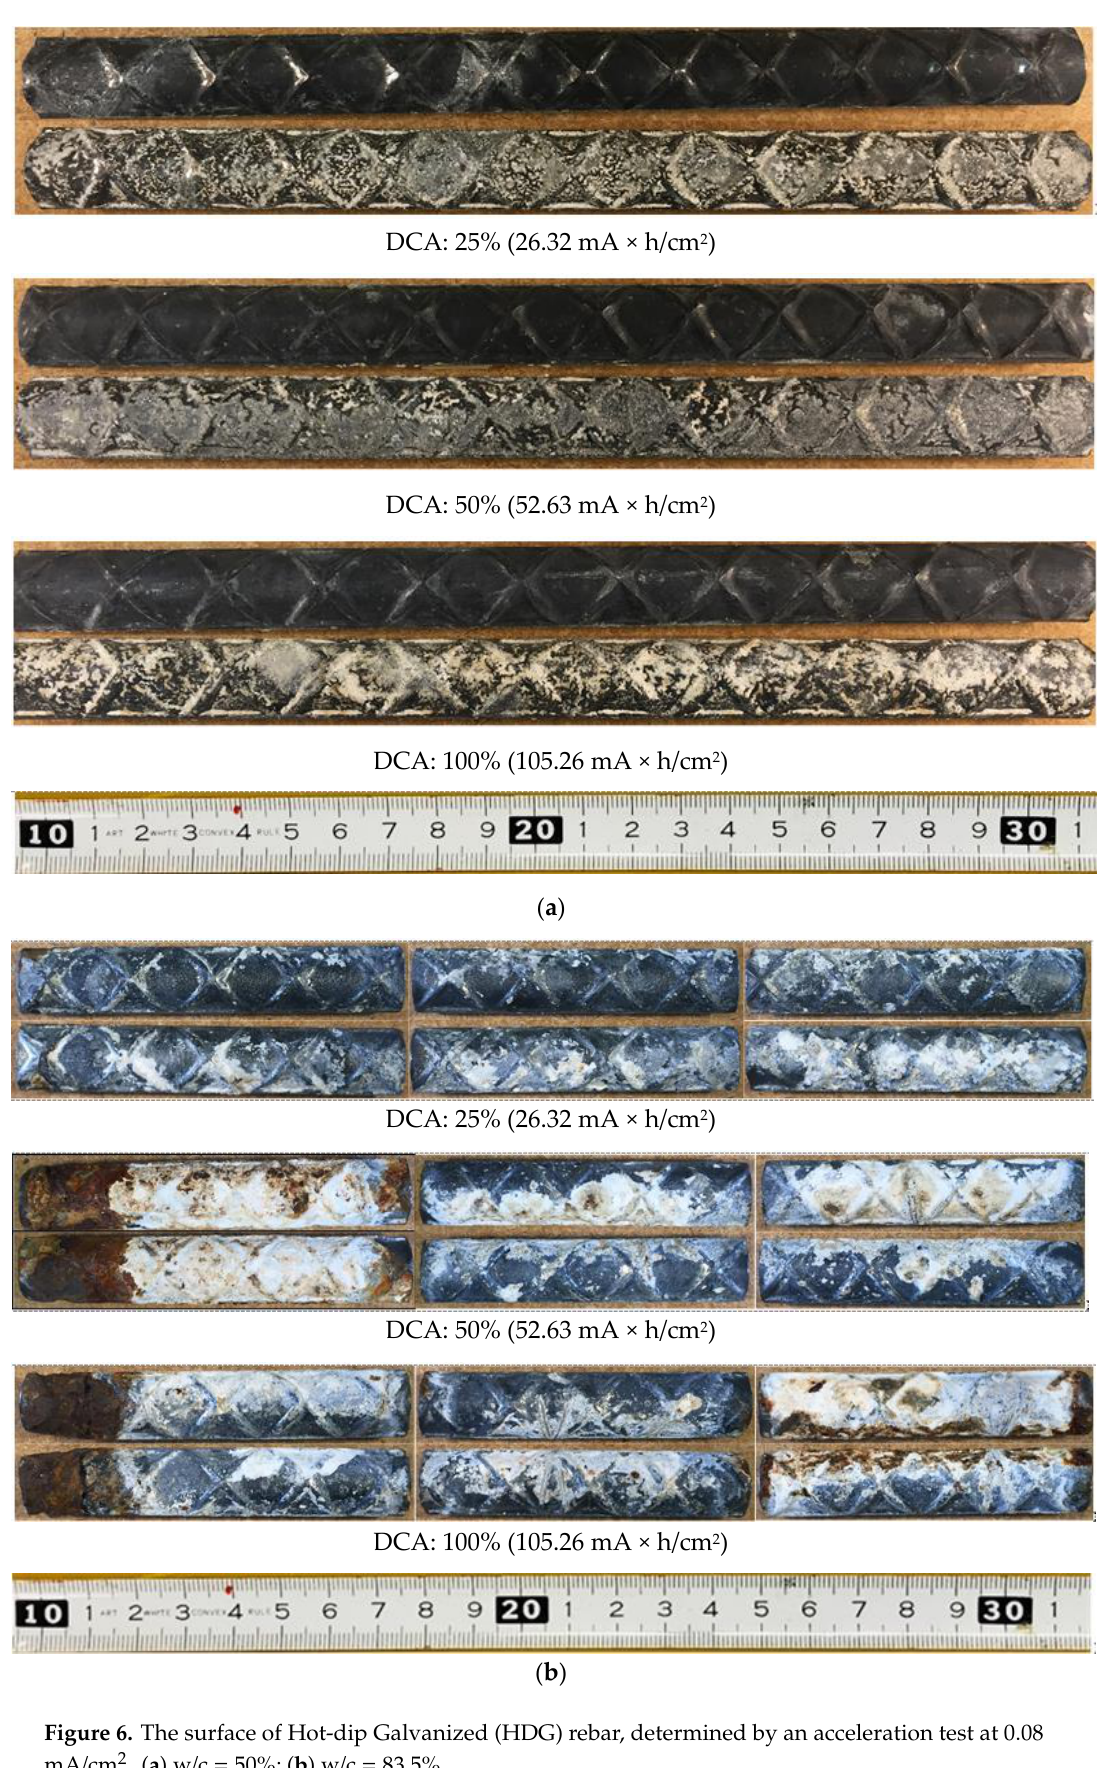
Figure 6. The surface of Hot-dip Galvanized (HDG) rebar, determined by an acceleration test at 0.08 mA/cm 2 . ( a ) w/c = 50% ; ( b ) w/c = 83.5% .